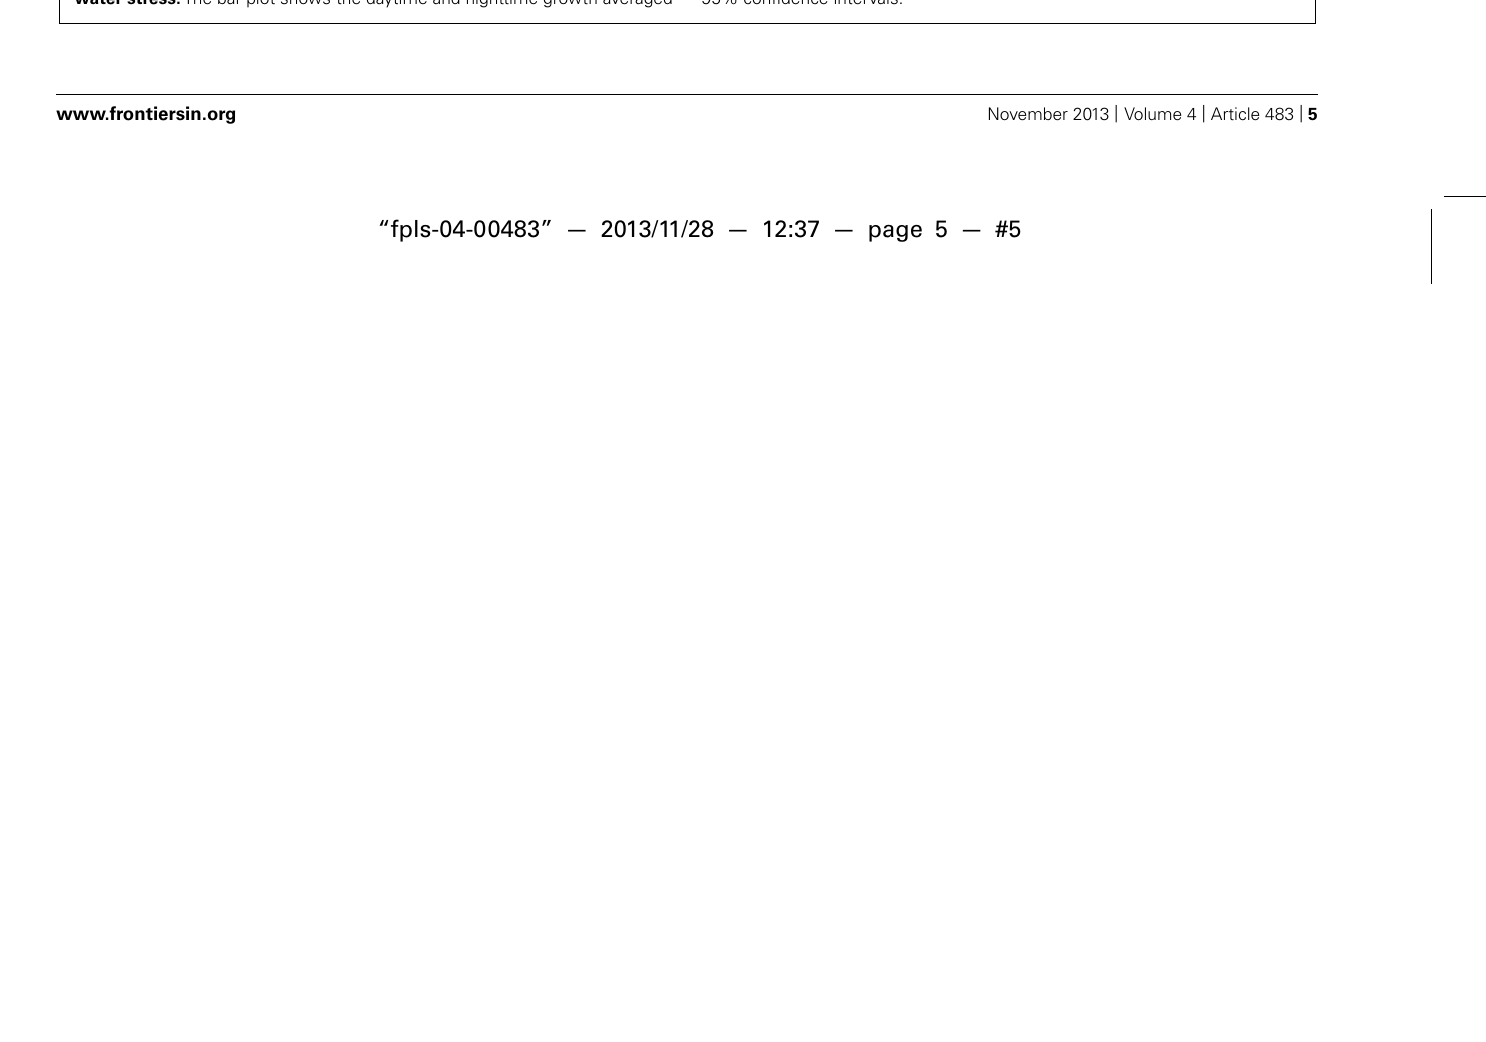
FIGURE 4 | Day/night leaf growth in Arabidopsis mutants affected in carbon metabolism and grown in well-watered conditions or under soil water stress. The bar plot shows the daytime and nighttime growth averaged